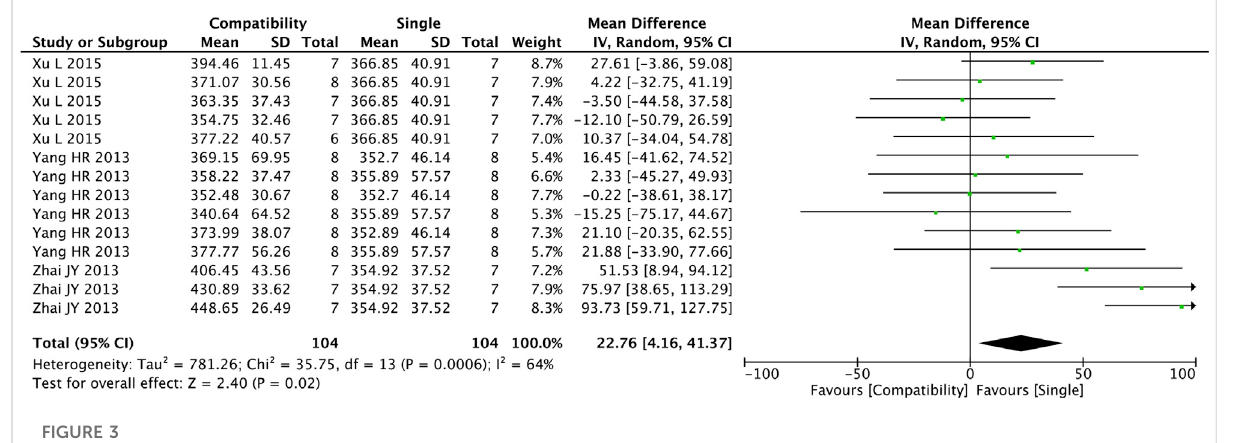
FIGURE 3 Forest plot of HR.